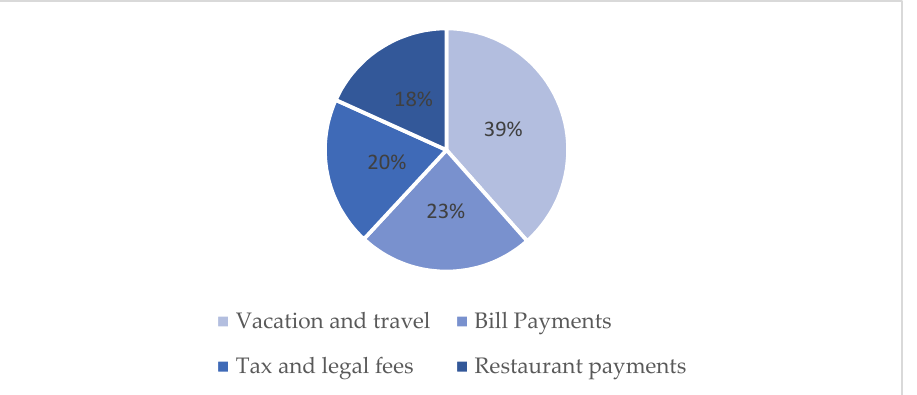
Figure 3. Firstly recommended campaigns.